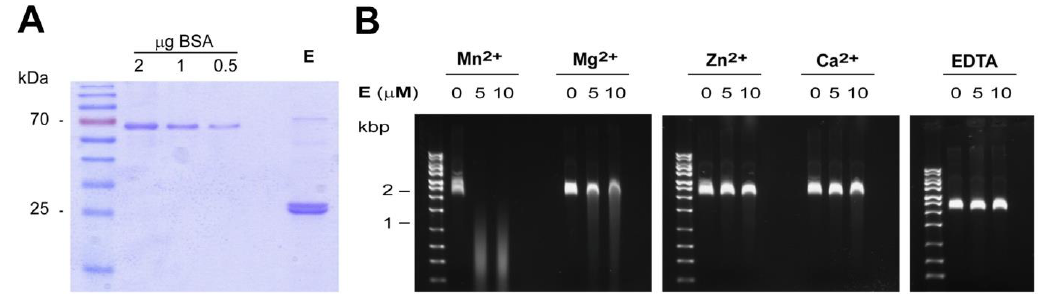
Figure 4. In vitro analysis of HTNV endonuclease. ( A ) The N-terminal 220 residues of HTNV L protein were expressed in E. coli and purified using TALON ® metal affinity resin as described in the methods section. A fraction of the purified material was separated by SDS-PAGE and stained with Coomassie blue. ( B ) Divalent cation-dependent nuclease activity. Single-stranded M13mp18 DNA (25 ng/μL) was incubated at 37 °C during 60 min in presence of 0, 5 or 10 μM of purified HTNV N-terminal domain and 2 mM of the indicated divalent cations, or 10 mM ethylenediaminetetraacetic acid (EDTA).